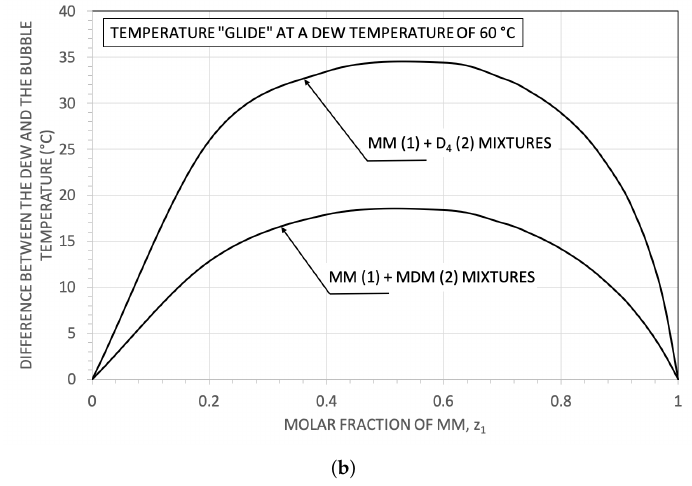
Figure 11. ( a ) Variation in the dew pressure and ( b ) variation in the temperature “glide” for two mixtures of siloxanes as a function of their molar composition. The dew temperature is fixed at 60°C.